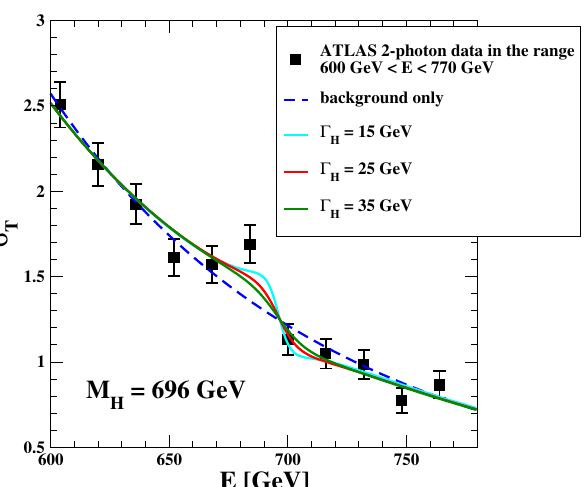
Figure 4. Three fits with Equation (22) to the data in Table 2, transformed into cross sections in fb. The χ 2 -values are 7.5, 8.8, 10.2, respectively, for Γ H = 15, 25, and 35 GeV.